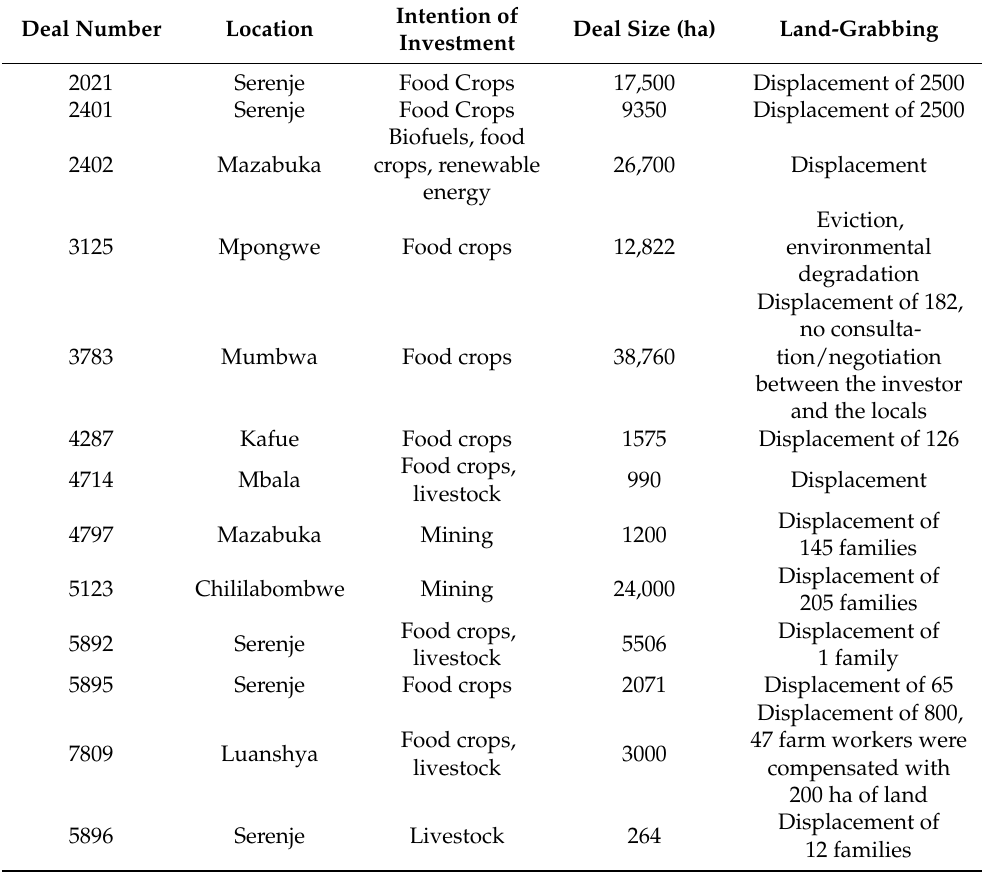
Table 4. Large-Scale Land Deals with land-grabbing cases (1970–2020)